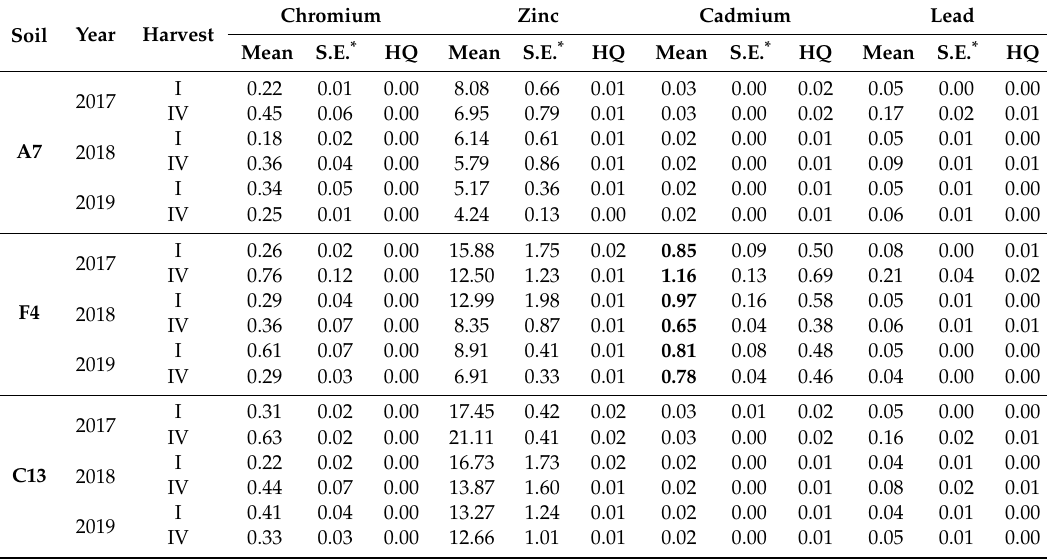
Table 3. PTE concentrations in leaves of Rocket Salad (mg kg − 1 fresh weight) at the first (I) and fourth (VI) harvest, and HQ